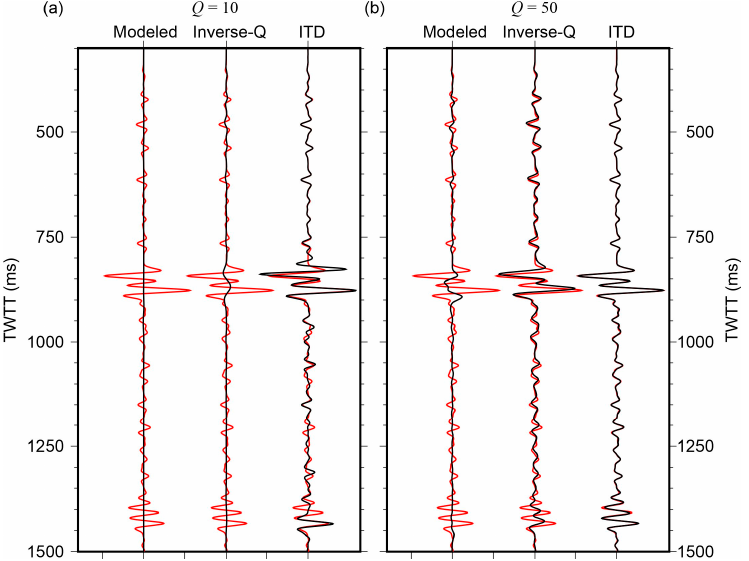
Figure 9. Comparisons between the attenuated reflection records modeled in Marmousi II model and its inverse- Q -filtered and ITD-corrected records (black lines, labels). Panels ( a ) and ( b ) correspond to modeled Q = 10 and 50, respectively. The identical red lines in all plots are the models in an elastic structure ( Q = ∞ ). All records are scaled equally, and, therefore, the attenuated records (labels “Modeled”) show low amplitudes in these plots, particularly in ( a ).